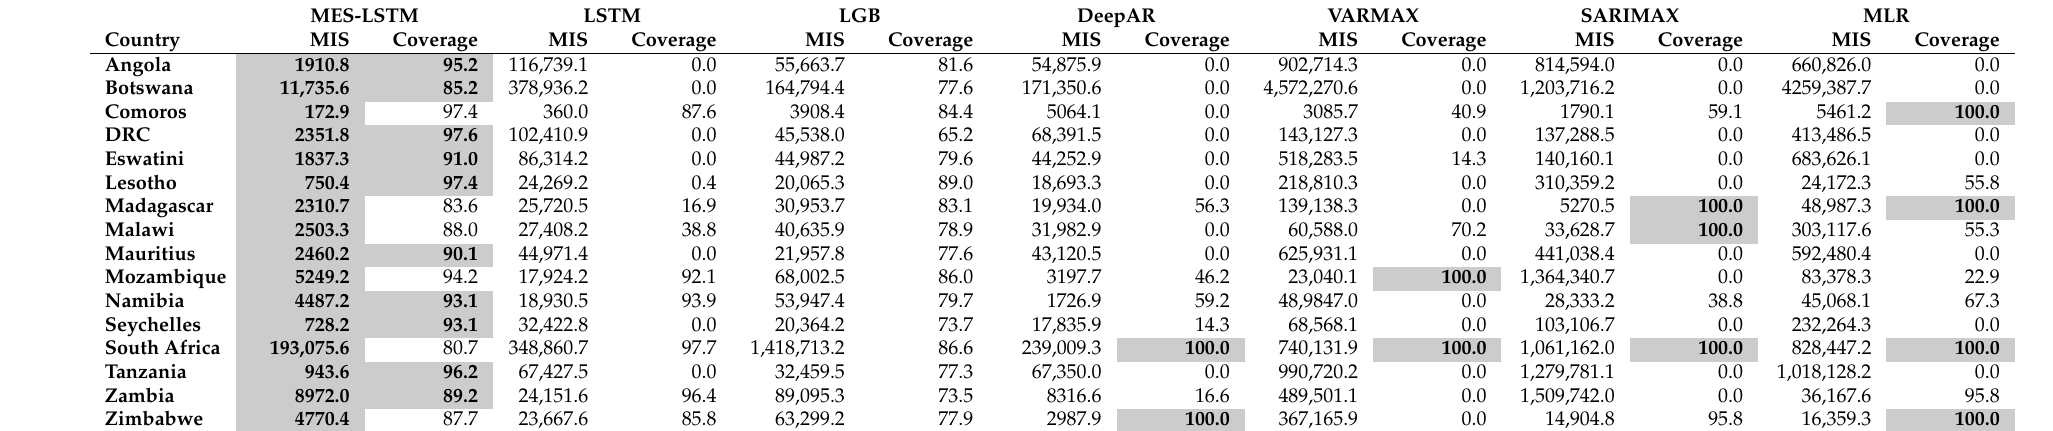
Table 6. Prediction Interval Accuracy Averaged Over All Trials for total cases in SADC ( α = 0.05).